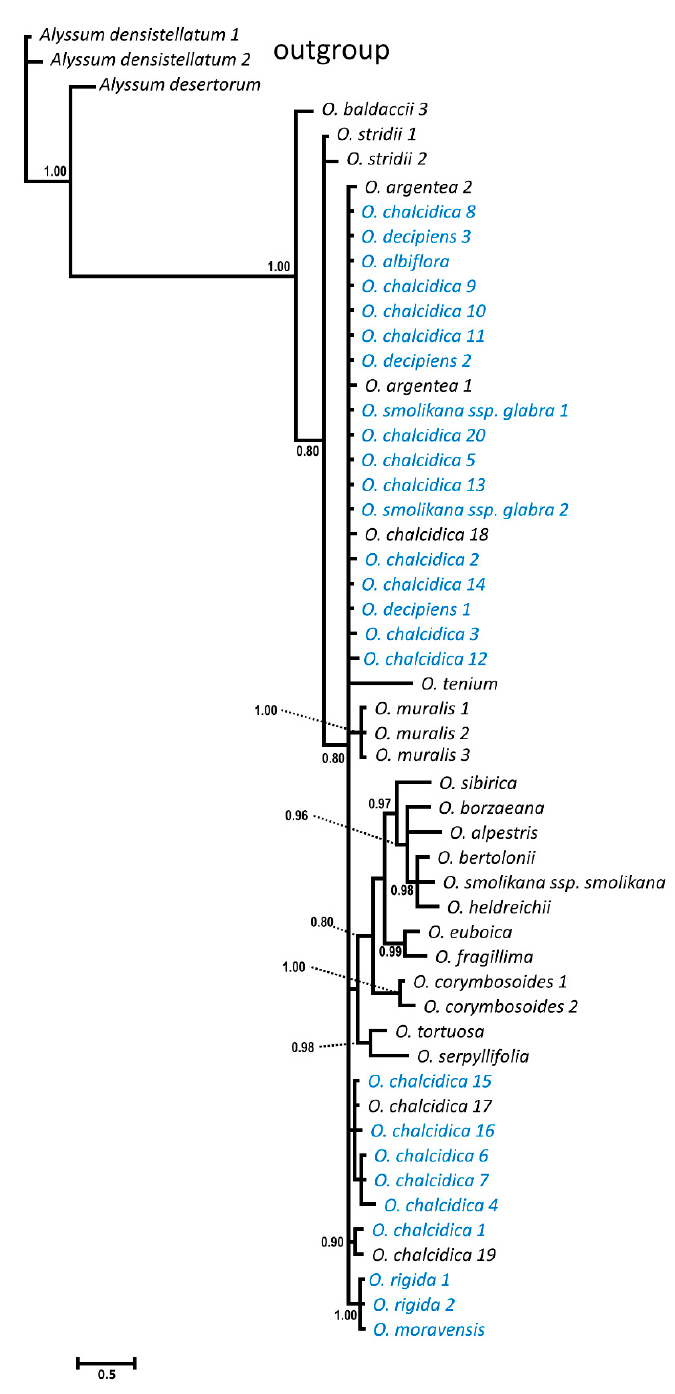
Figure 1. Bayesian consensus phylogram from ITS-5.8S sequences showing relationships of taxa and accessions of Odontarrhena from Albania (in blue). Posterior probability values > 80% are shown at the corresponding nodes.